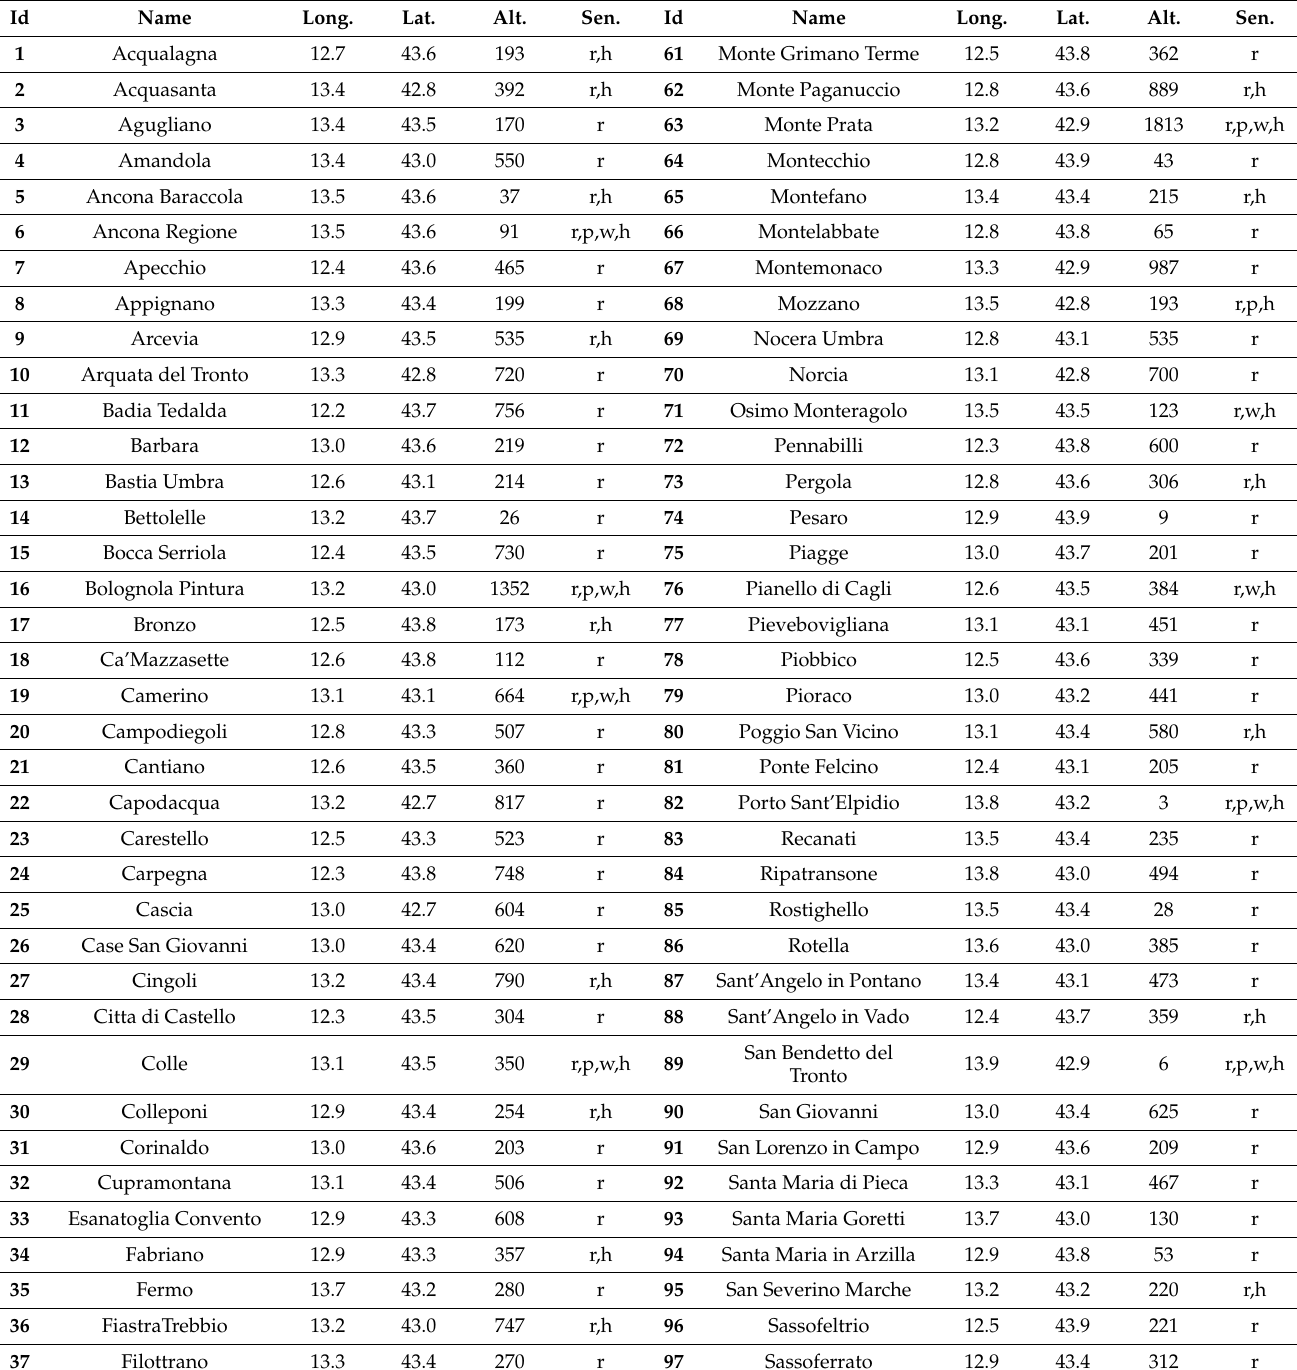
Table 1. Name , name of the weather stations, Long. , longitude, Lat. , latitude, Alt. , altitude, Sen. , equipment of sensors to measure climatic variables r (rain gauge), p (barometer), w (anemometer), h